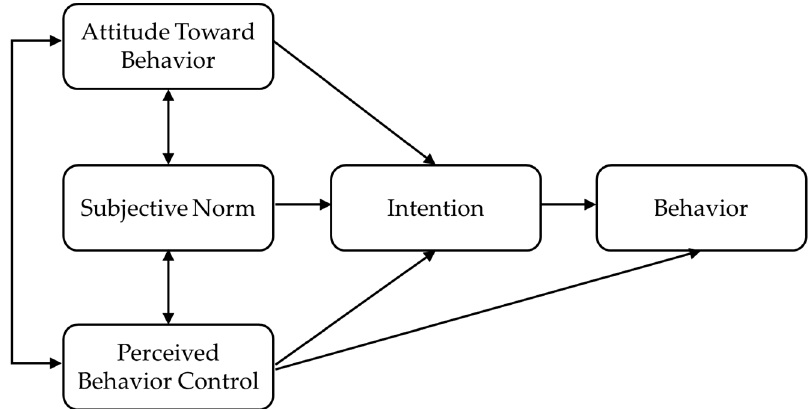
Figure 1. Theory of planned behavior (TPB) framework, adapted from